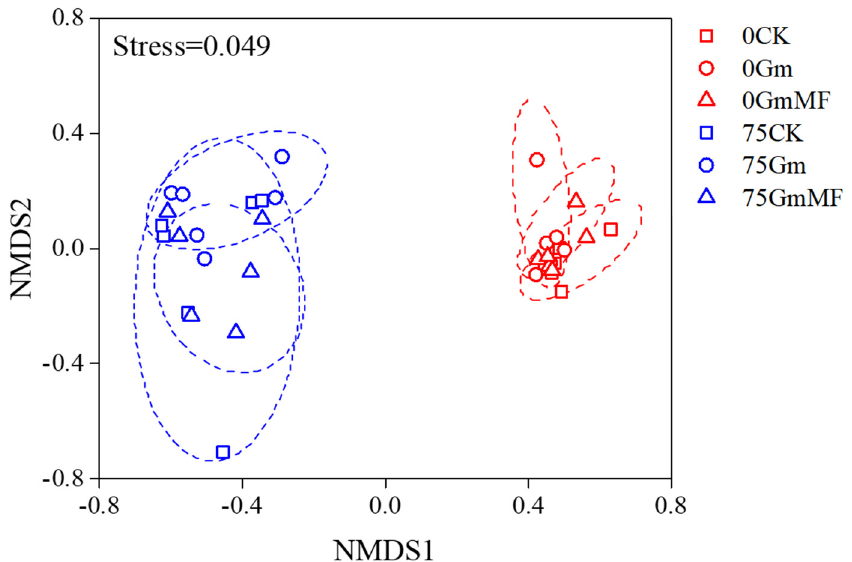
Figure 5. Overview of the metabolomic reprogramming in maize plant roots under CK, Gm treatment, and Gm + MF treatment at 0 and 75 mM NaCl conditions. Red symbols: 0 NaCl and blue symbols: 75 NaCl. Square: CK, circle: Gm and triangle: Gm + MF. Ellipses represent 95% confidence intervals around the centroid of all samples. Table 2. Effects of single and dual-inoculants on the metabolite profiles in maize plant roots.